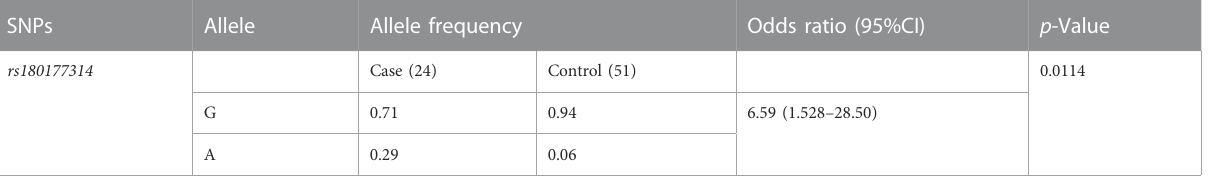
TABLE 4 Allele frequencies recorded in controls and patient samples.